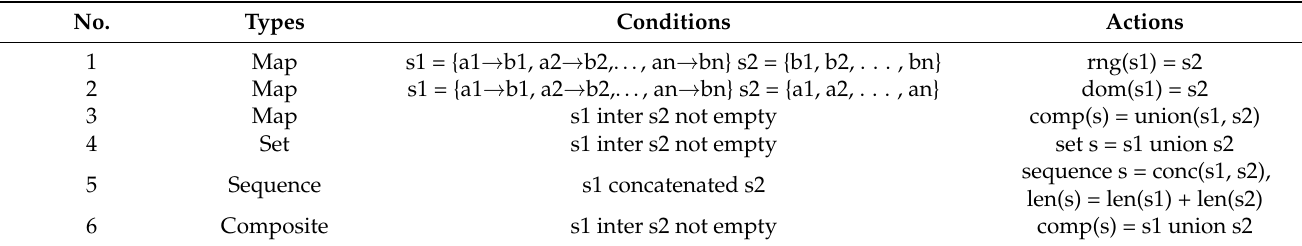
Table 1. Rules for declaration integration based on composite type